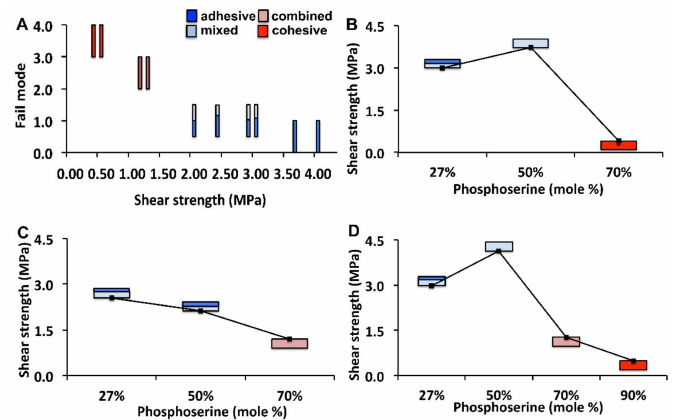
Figure 4. Failure mode analysis. ( A ) The failure mode distribution of PMC formulations shown in Figure 3C plotted against shear strength. ( B – D ) Box plots of failure mode include the average shear strength (line plot overlayed) for PMCs cured in PBS ( B ), in PBS with accelerant H 3 PO 4 ( C ), or 100% humidity ( D ). Boxes located above the shear strength data point represent the proportion of samples that failed adhesively (adhesive and mixed mode failure), boxes located below the shear strength data point represent the proportion of samples that failed cohesively (combined and cohesive failure mode). Box color: dark blue indicates adhesive failure, light blue indicates mixed mode failure, pink indicates combined mode failure, and red indicates cohesive